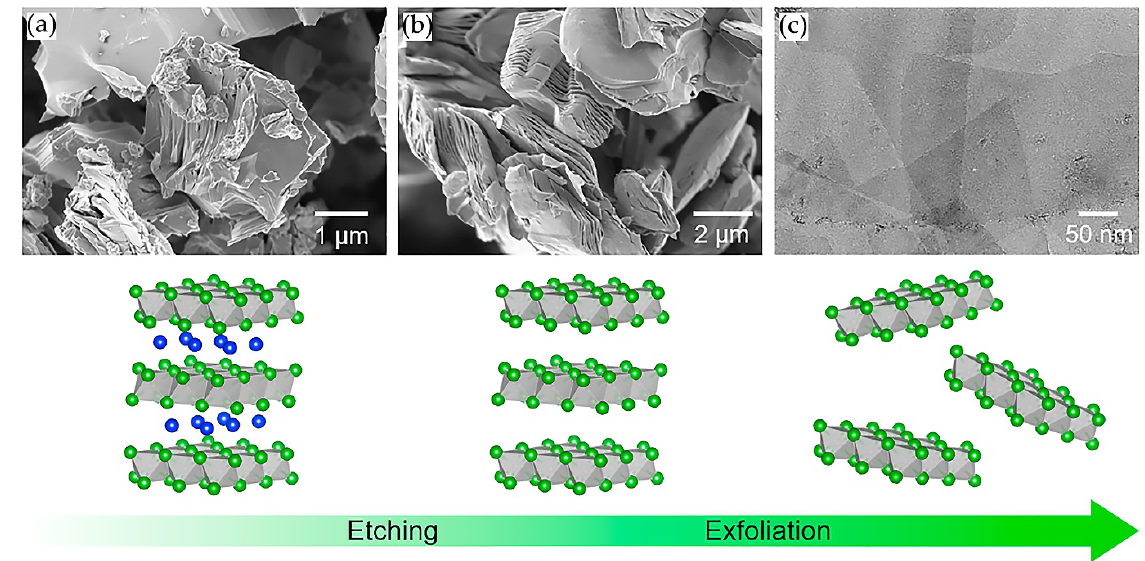
Figure 9. The process of synthesis of MXenes. ( a ), a three-dimensional precursor, which is used to etch certain elements; ( b ) a multilayer MXene obtained after etching; ( c ) stratification into single nanolayers. Reprinted with permission from [61] 2019 Elsevier.